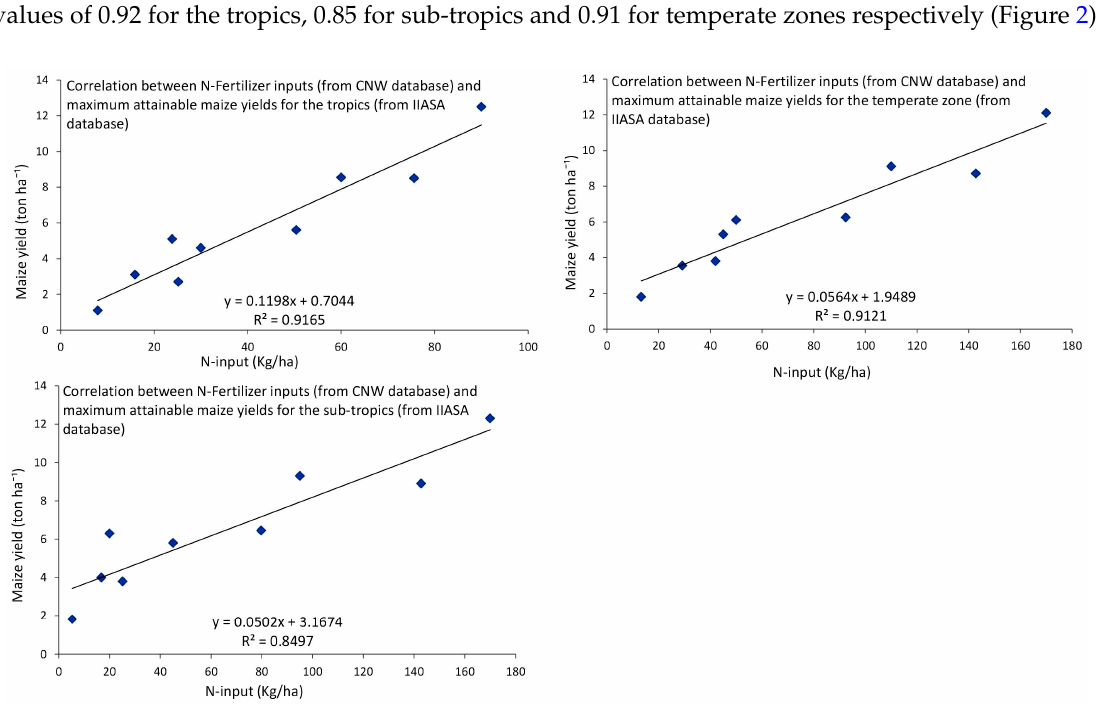
Figure 2. Correlation between N-Fertilizer inputs (from CNW database) and maximum attainable maize yields for the tropics, sub-tropics and temperate agro-climatic zones (from GAEZ database) .